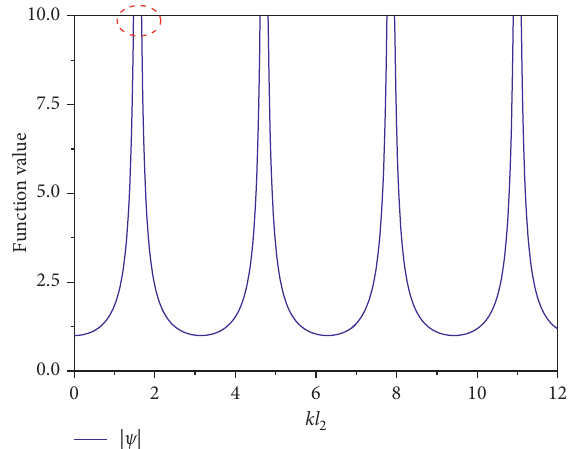
Figure 8: Absolute values of the function ψ .